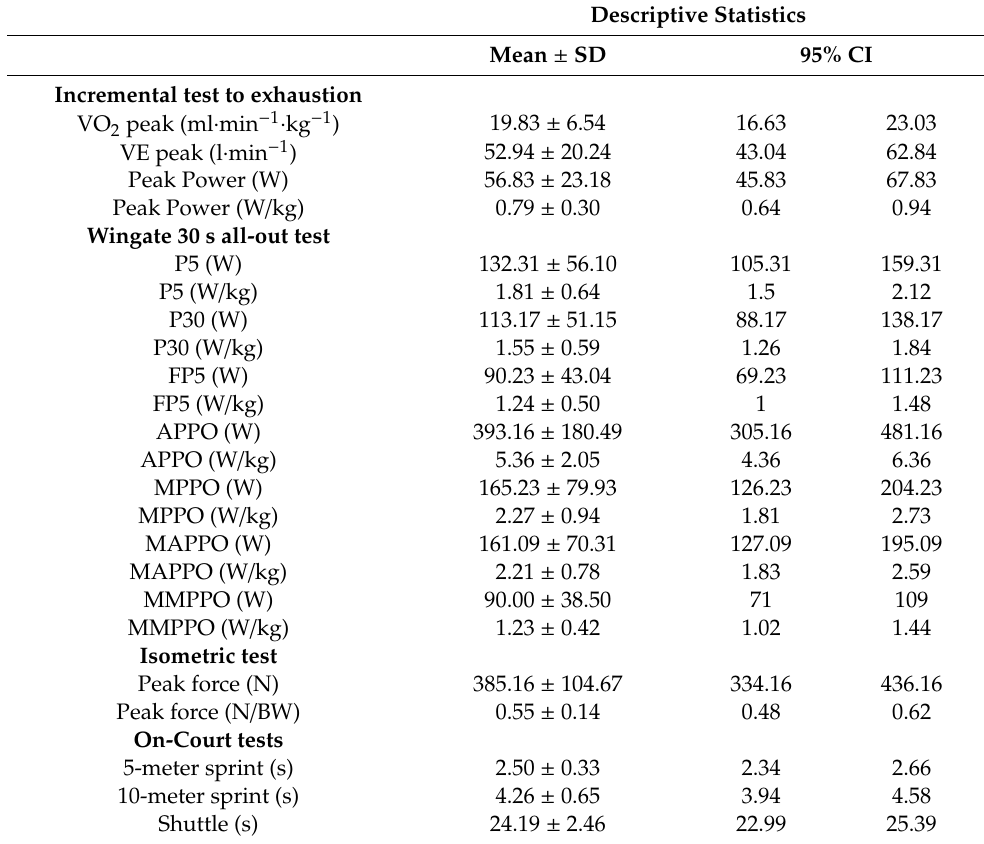
Table 1. Descriptive results of the aerobic and anaerobic tests of the Italian wheelchair rugby team (VO 2 peak, peak of the oxygen consumption; VE, ventilation; P5, highest mean power over a successive 5-second interval; P30, mean power over 30 s; FP5, mean power of the last 5-second interval; APPO, absolute peak power output in the first 5 s; MPPO, minimum peak power output in the last 5 s; MAPPO, integral mean of the power signal over thrusts including APPO; MMPPO, integral mean of the power signal over thrusts including